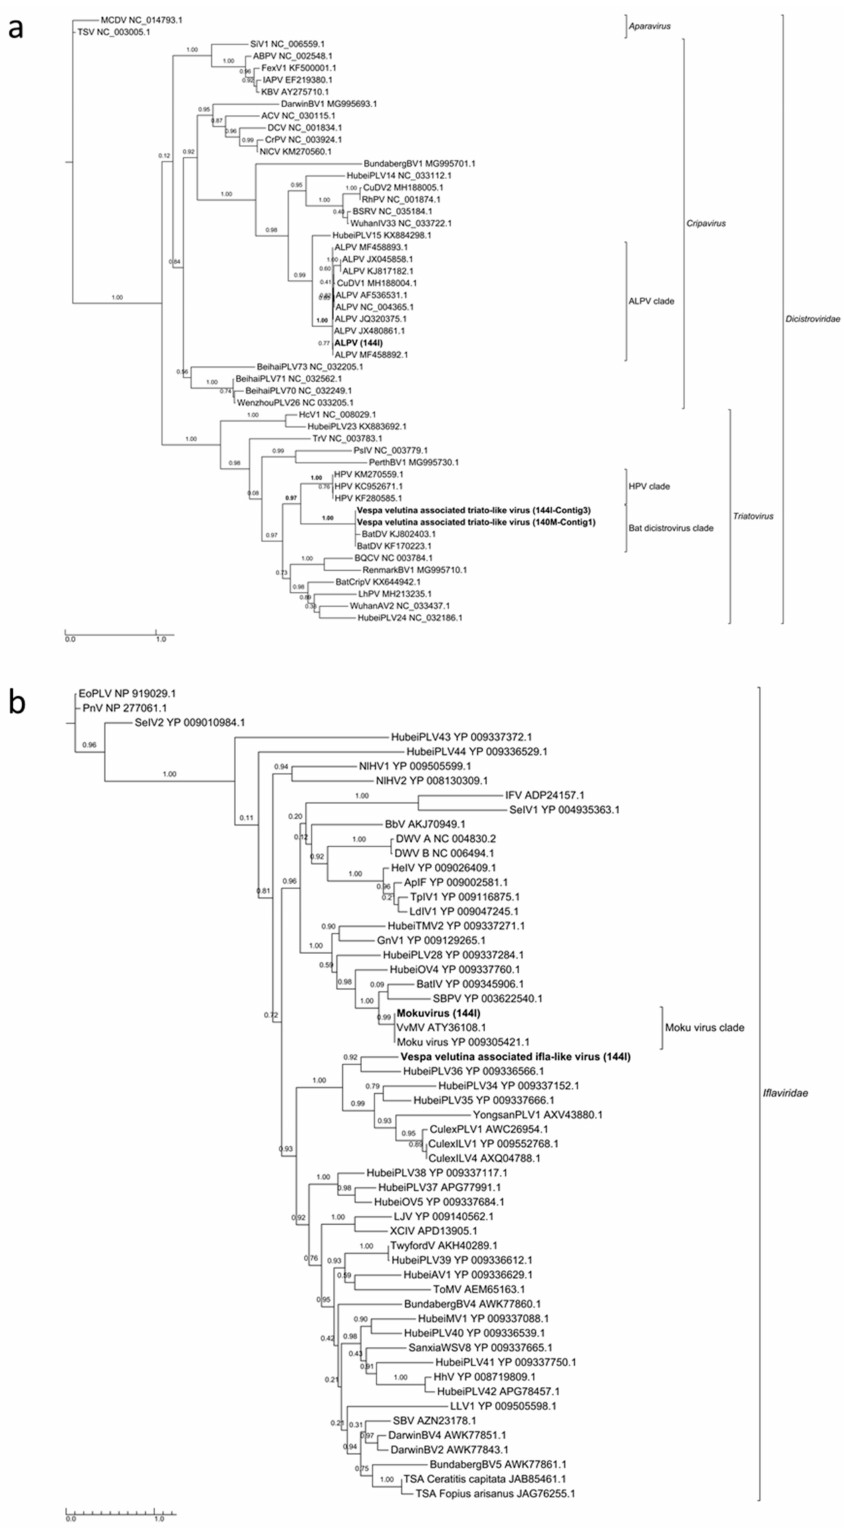
Figure 3. Maximum likelihood phylogeny of the replicase genes of ( a ) ALPV and Vespa velutina associated triato-like virus (372 aa, LG + I + G + F model), and ( b ) Moku virus and Vespa velutina associated ifla-like virus (338 aa, LG + I + G + F model) detected in hornets. The complete virus names are shown